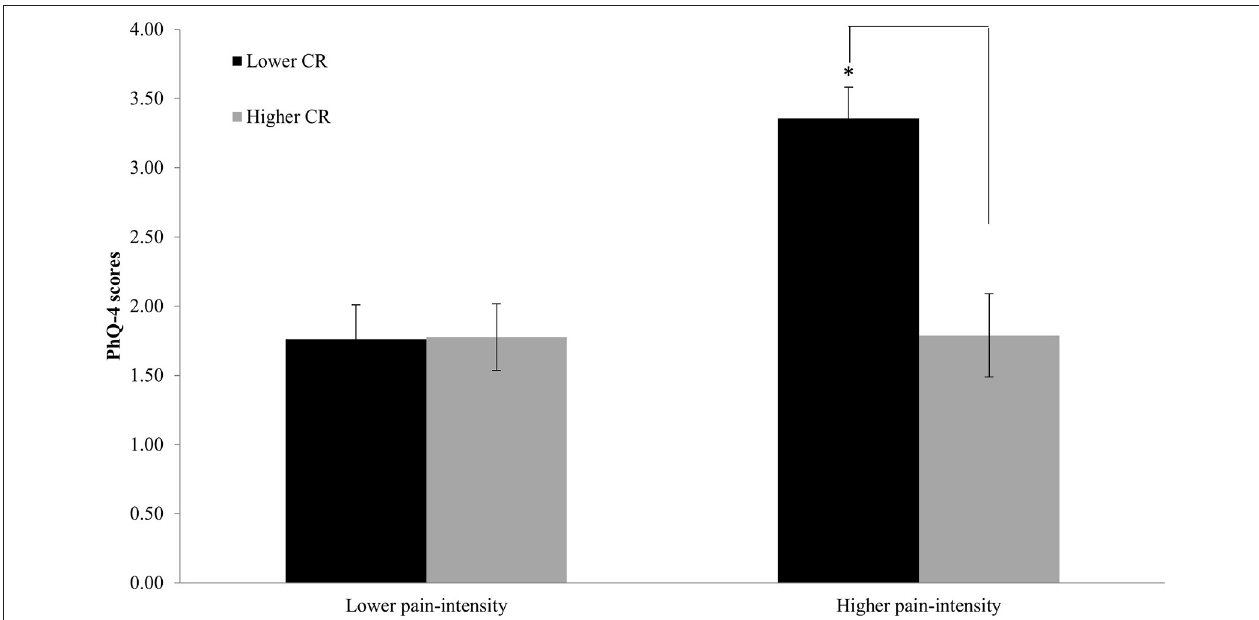
FIGURE 4 | Distribution of CP participants (Higher pain intensity/Lower pain intensity; Higher CR/Lower CR) according to the percentile 50. Participants with higher CR showed less impact on mental health in the higher pain-intensity group. * p <